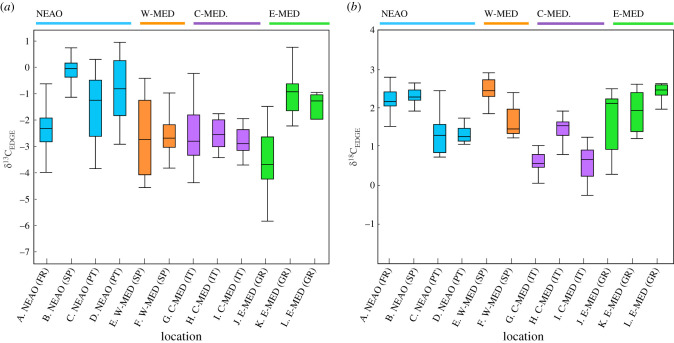
Box plot of cuttlebone (a) δ13CEDGE and (b) δ18OEDGE values by site and region for of Sepia officinalis. Different colour box plots shown for the four major regions.